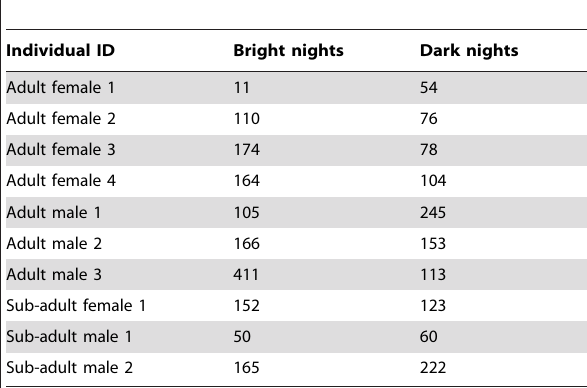
Table 1. Number of observations collected on bright and dark nights for individuals.